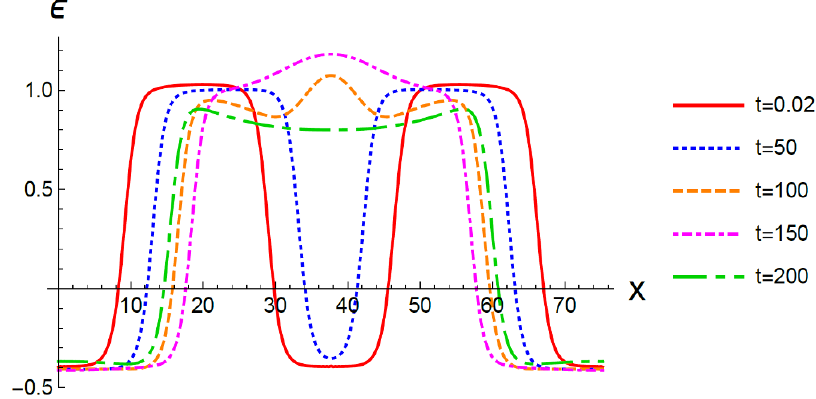
Figure 11 . Energy density pro(cid:12)le obtained solving the Einstein-matter equations with initial conditions